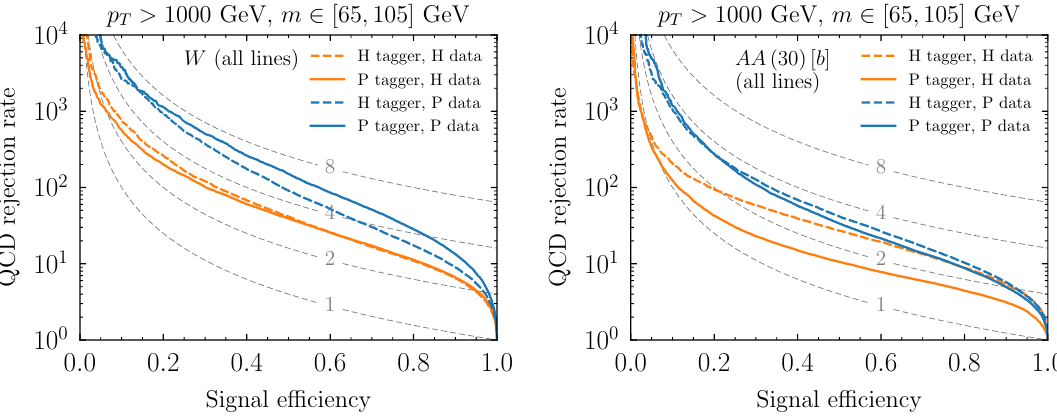
Figure 14 . Comparison of results for anti-QCD taggers using Herwig and Pythia simulated showers, for W bosons (left) and stealth bosons